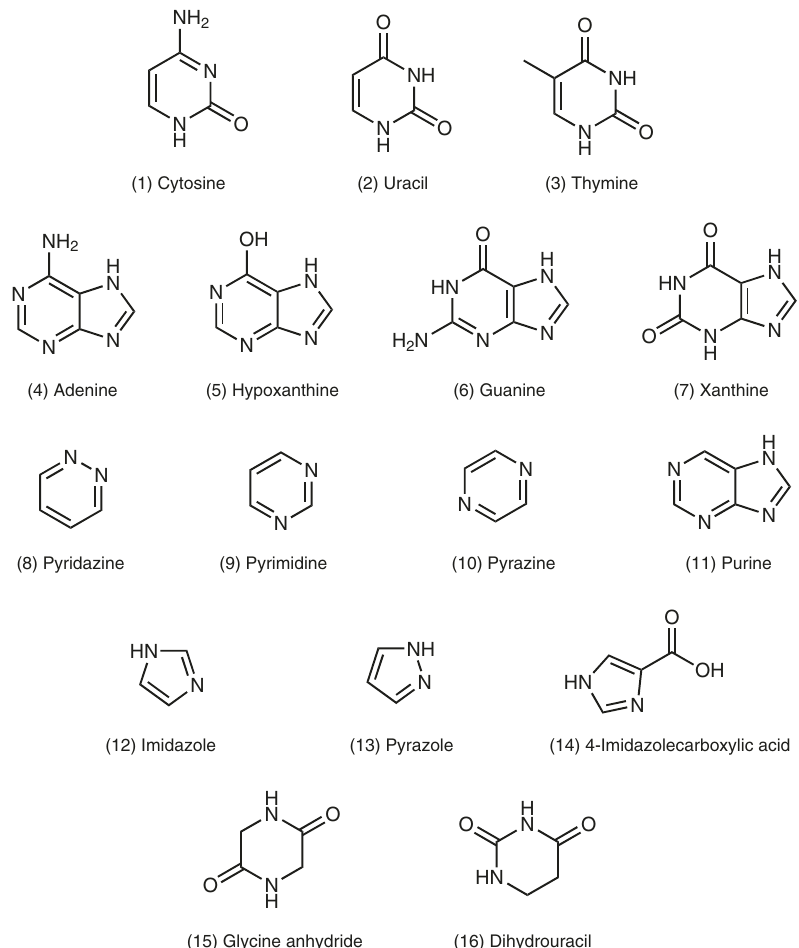
Fig. 1 Names and structures of the products detected (except guanine) in the organic residues. The numbers in parentheses are used to identify the relevant compounds in Table 1, where the yield of each species is